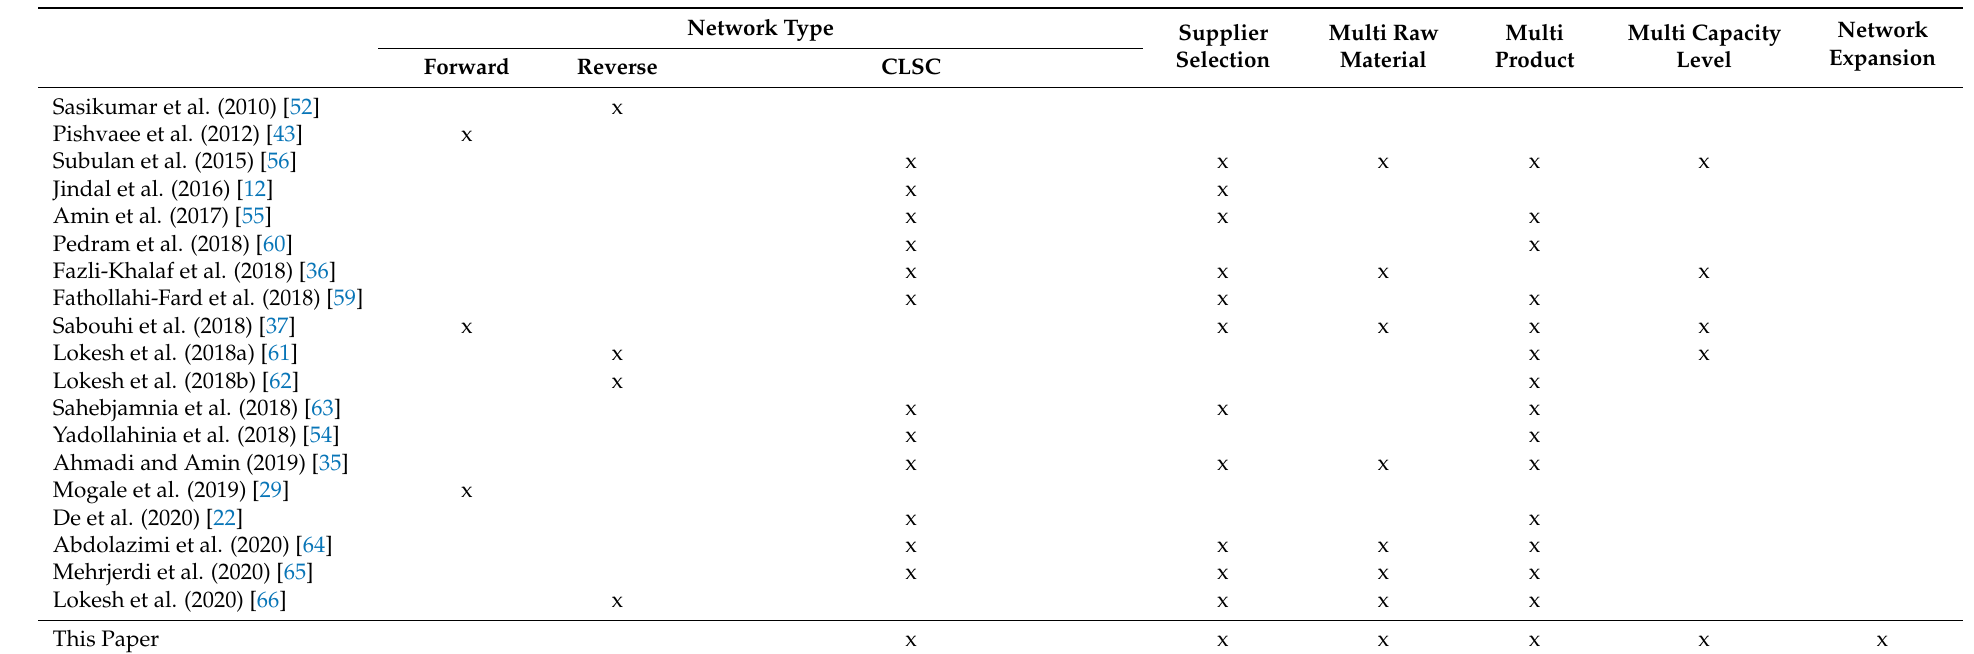
Table 1. Research